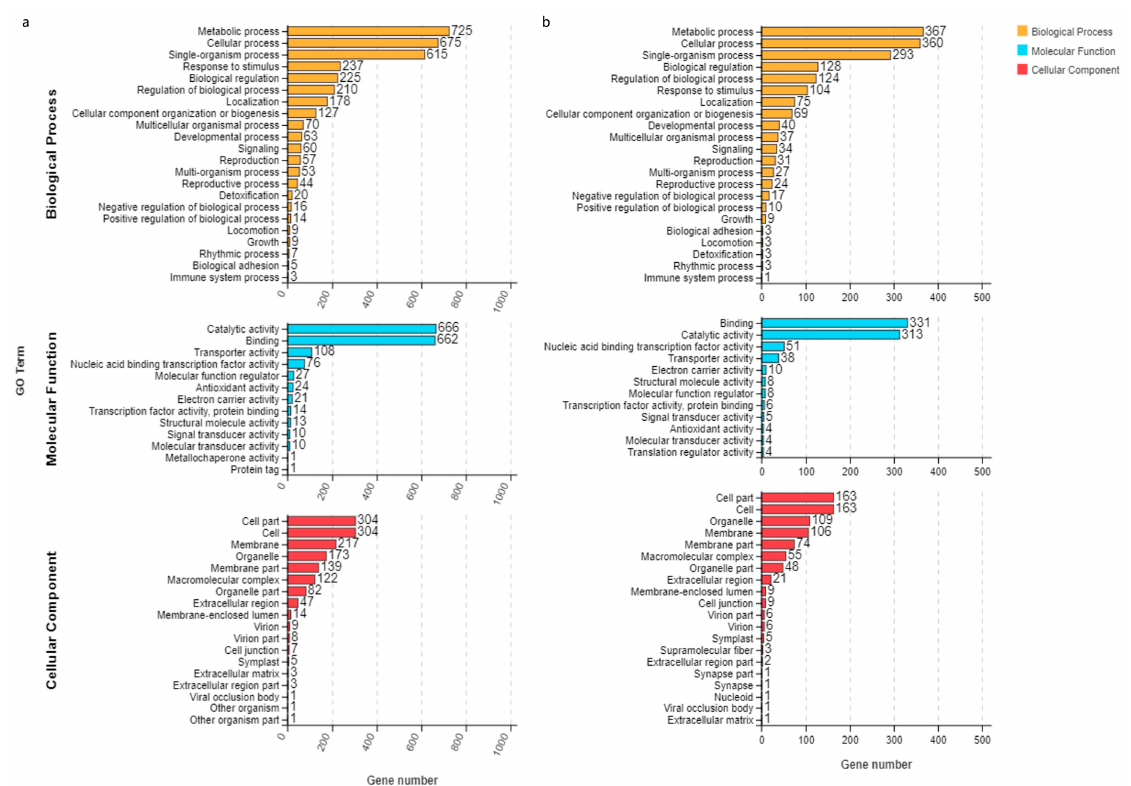
Figure 5. GO results for DEGs between CK and the ( a ) CT1 and CT2 (>0 °C) and ( b ) CT3 and CT4 (<0 °C) treatment groups.